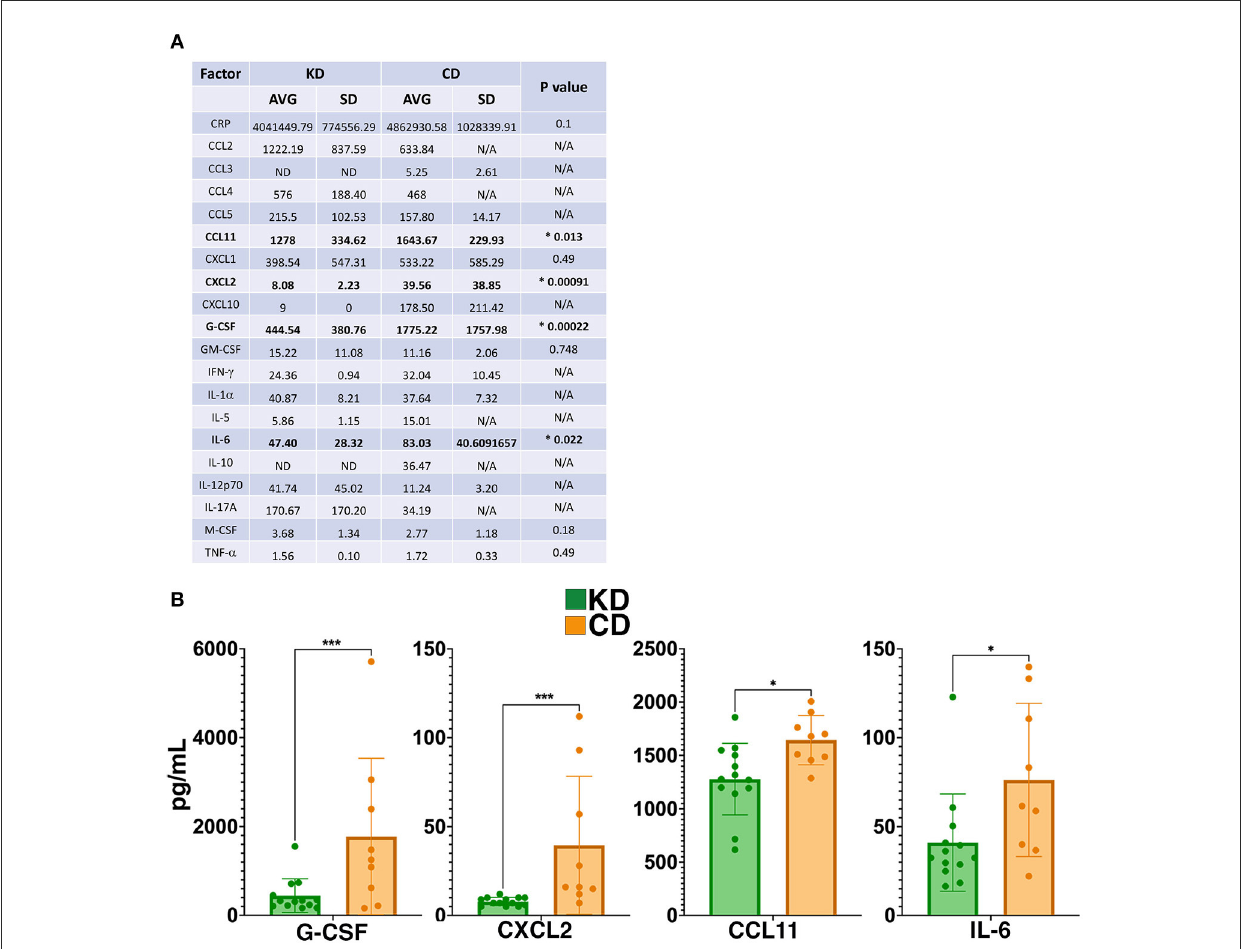
FIGURE6 The KD suppresses levels of G-CSF, CXCL2, and other markers of inflammation. (A) Table of cytokine and chemokine measurements from the plasma of EAE mice. Asterisks and bolding highlight factors that are statistically significantly different as a function of diet. “AVG” denotes average and “SD” denotes standard deviation. “ND” indicates that all samples analzyed were below the detection limit of the assay and “N/A” indicates that insufficient numbers of samples were within the detectable range of the assay to perform statistical analyses. (B) Graphical presentation of the four factors that differ in the plasma 21 dpi as a function of diet. EAE mice consumed either the KD (green) or a CD (orange), 4–8 mice per diet per sex from ≥ 2 independent experiments. Statistical significance for cytokines and chemokines was determined with robust linear regression using the rlm function in MASS R package. p -values relied on robust F-Testing (Wald) performed with f.robftest function from sfsmisc package. For graphs in (B) , * p < 0.05, *** p <